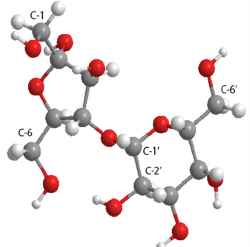
Figure 7. Structural conformation of the lactulose, evidencing the less steric ‐ hindered C ‐ 1 and C ‐ 6 ′ C ‐ OH positions.